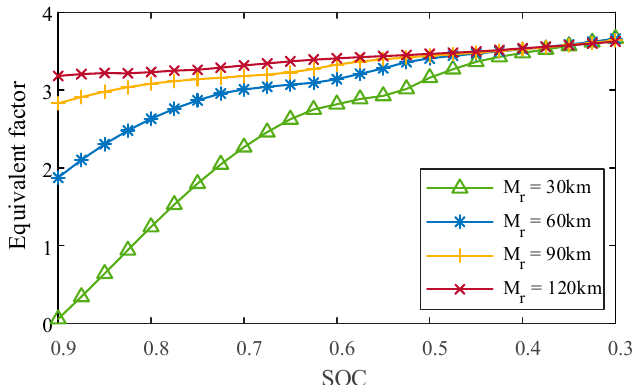
Figure 8. Equivalence factor recognized by the neural network.